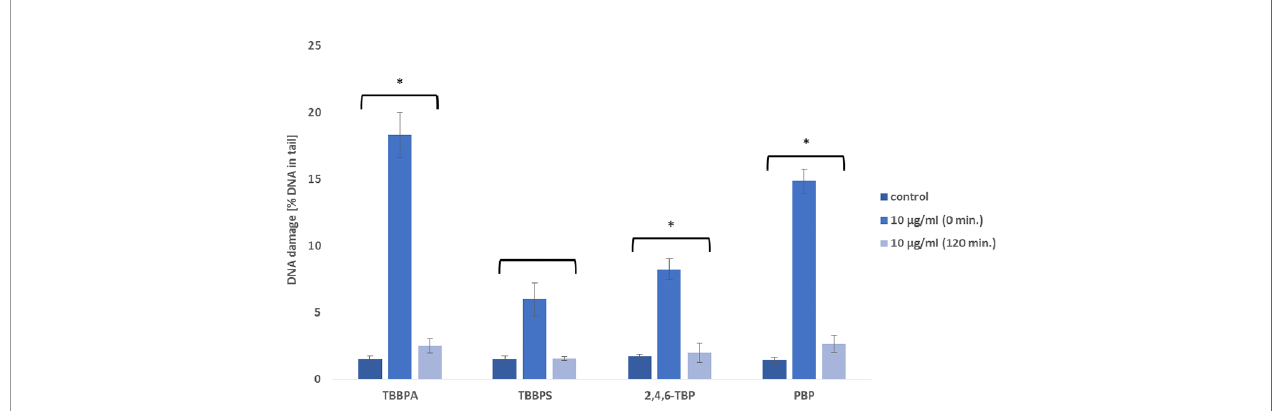
FIGURE 5 | DNA repair capacity. Repair of damaged DNA in human PBMCs after 24 h of incubation with TBBPA, TBBPS, 2,4,6-TBP and PBP at 10 µg/mL. The repair was assessed after 120 min. of post incubation of the cells in medium deprived of these substances as a decrease in the extent of DNA damage (measured as the percentage of the DNA in comet tail) using the alkaline version of the comet assay. Mean ± SD was calculated from 3 individual experiments (3 blood donors). Statistically different from negative control at *P<0.05. Statistical analysis was conducted using one-way ANOVA and a posteriori Tukey test.